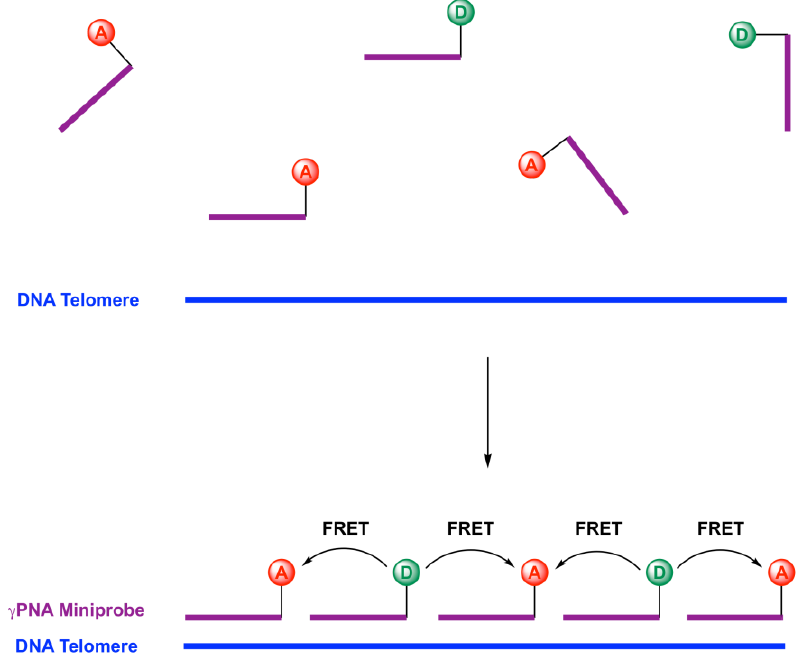
Figure 1. Alternating gammaPNA (γPNA) miniprobes on a DNA telomere for effective FRET signal. D = SCy3 donor, A = X647 acceptor.